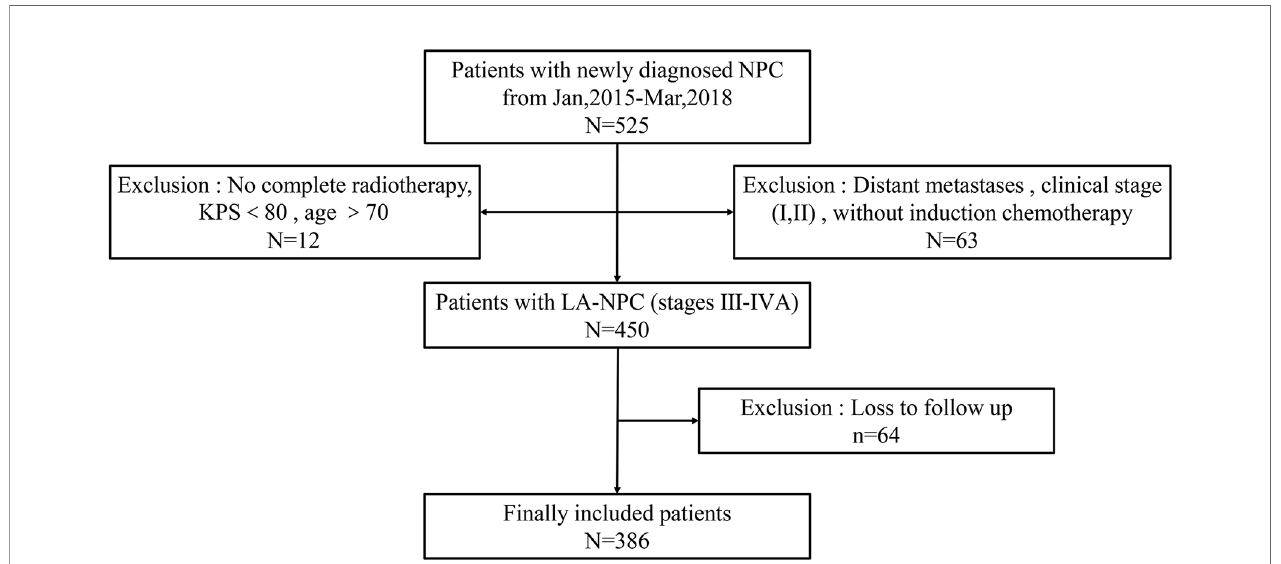
FIGURE 1 | Schematic for patient selection and inclusion in this study. NPC, nasopharyngeal carcinoma; LA-NPC, locally advanced nasopharyngeal carcinoma; KPS, Karnofsky